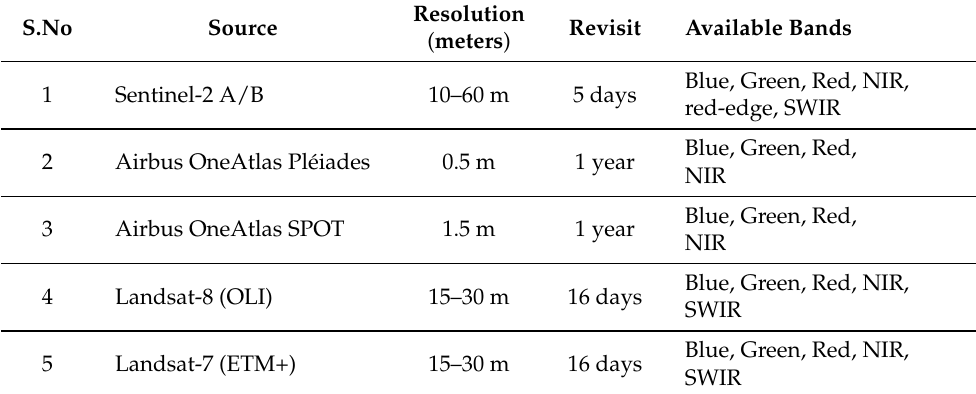
Table 1. Multispectral image sources ordered based on the priority of mapping in the dataset.